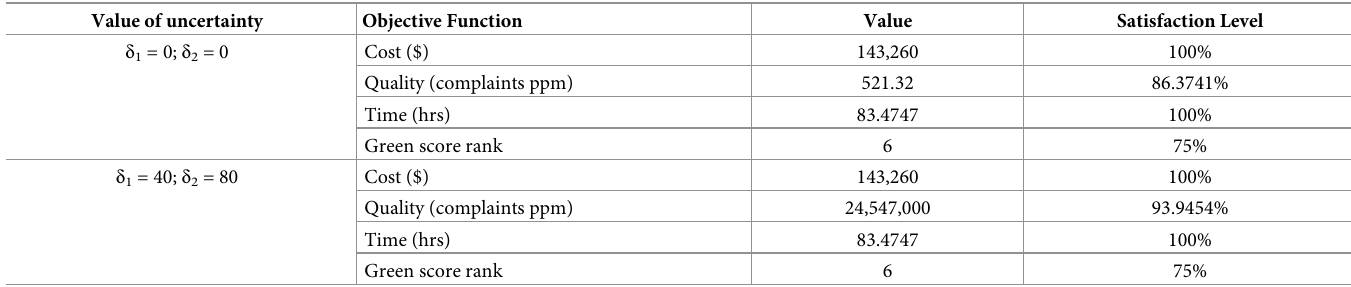
Table 17. Effect of uncertainty.